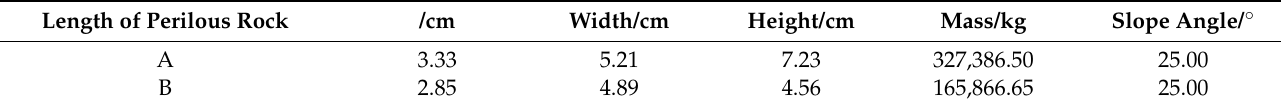
Table 4. Parameter indexes of the perilous